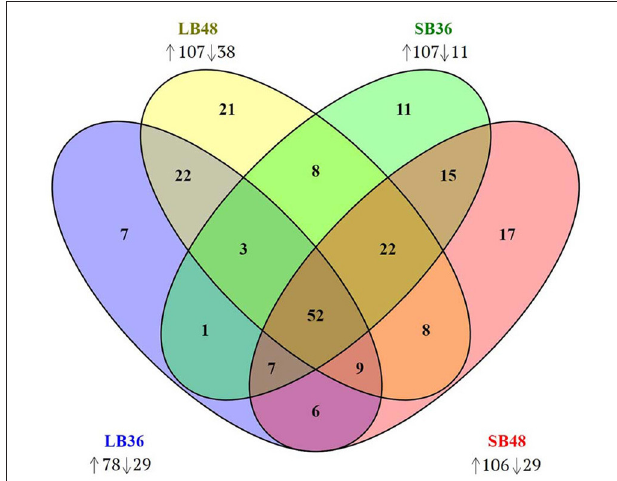
FIGURE 6 | Venn diagram of CAZyme-encoding genes observed in treatments LB36, LB48, SB36, and SB48. Differentially expressed genes were considered significant if relative expression in comparison to equivalent treatments with glucose as carbon source showed at least a 2-fold change and considering a false discovery rate (FDR)-adjusted P -value (padj) at 0.01. Arrows pointing up or down: CAZyme-encoding genes up-regulated or down-regulated in each